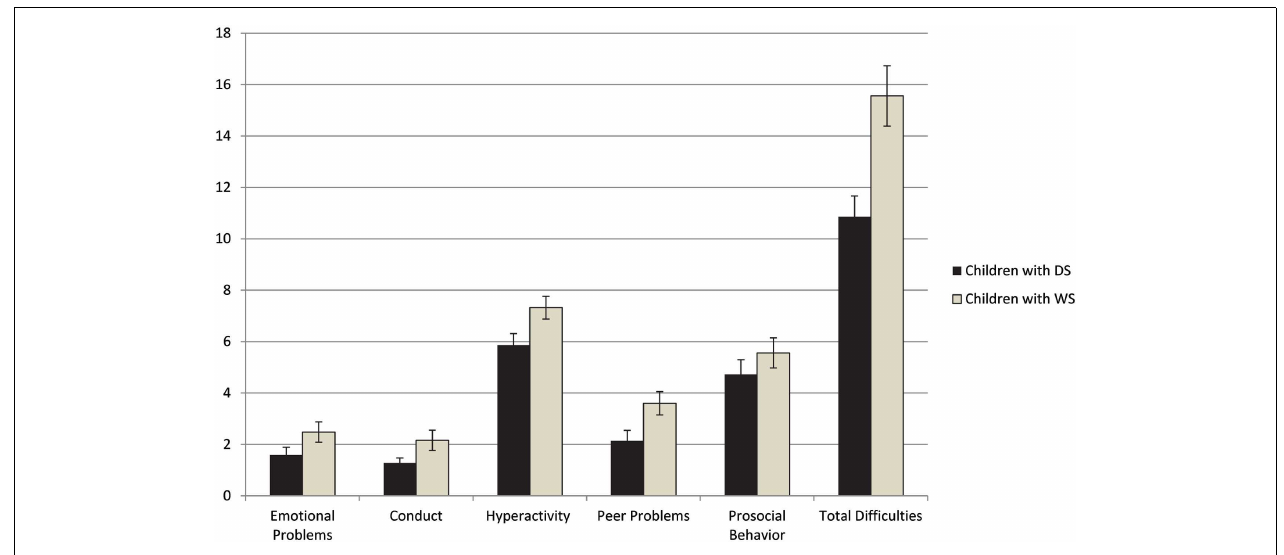
FIGURE 1 | Socio-behavioral strengths and weaknesses across syndromes. Note. Subscale raw scores andTotal difficulties on SDQ for children with DS or